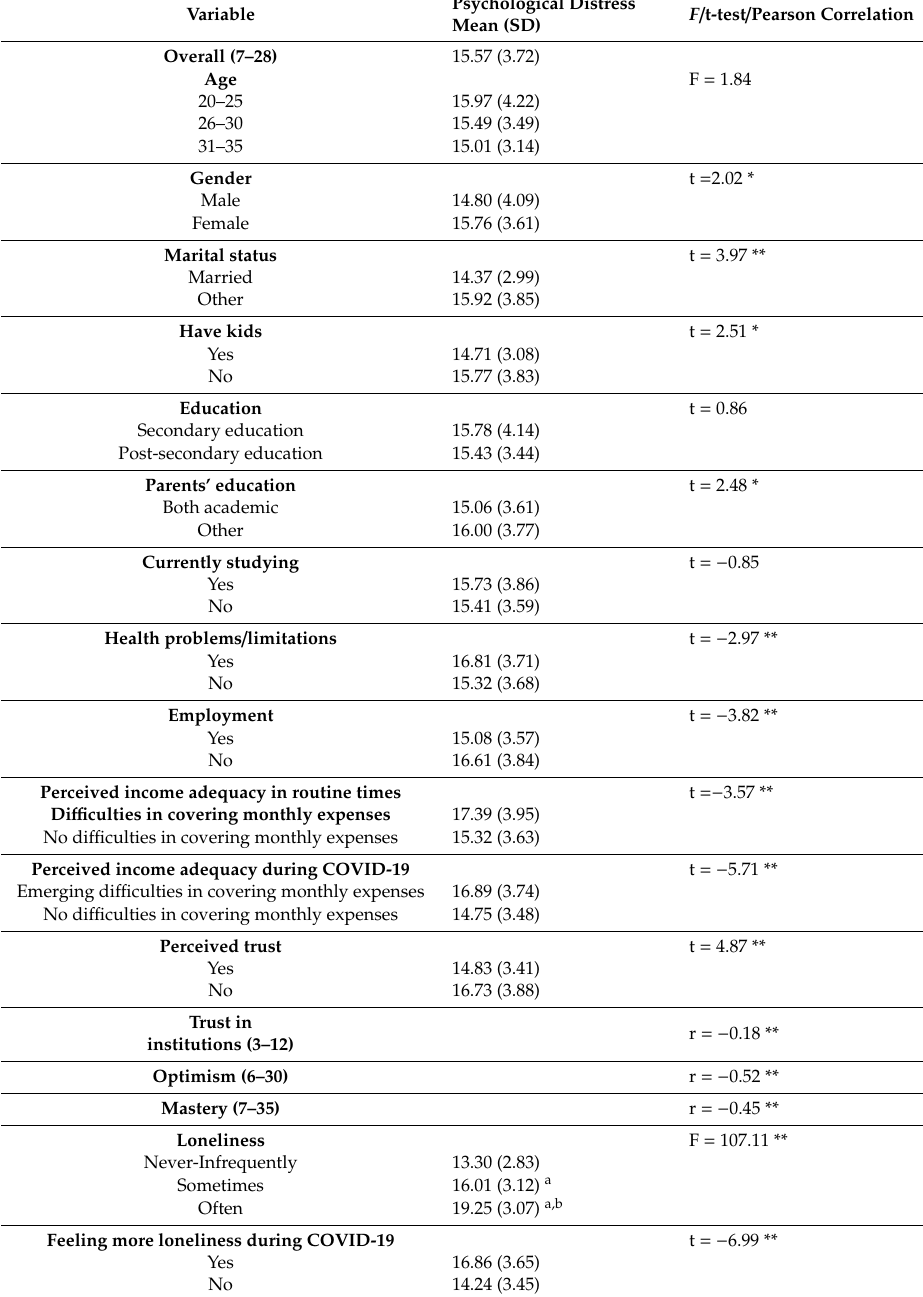
Table 2. Psychological distress (PD) by the study variables (N =